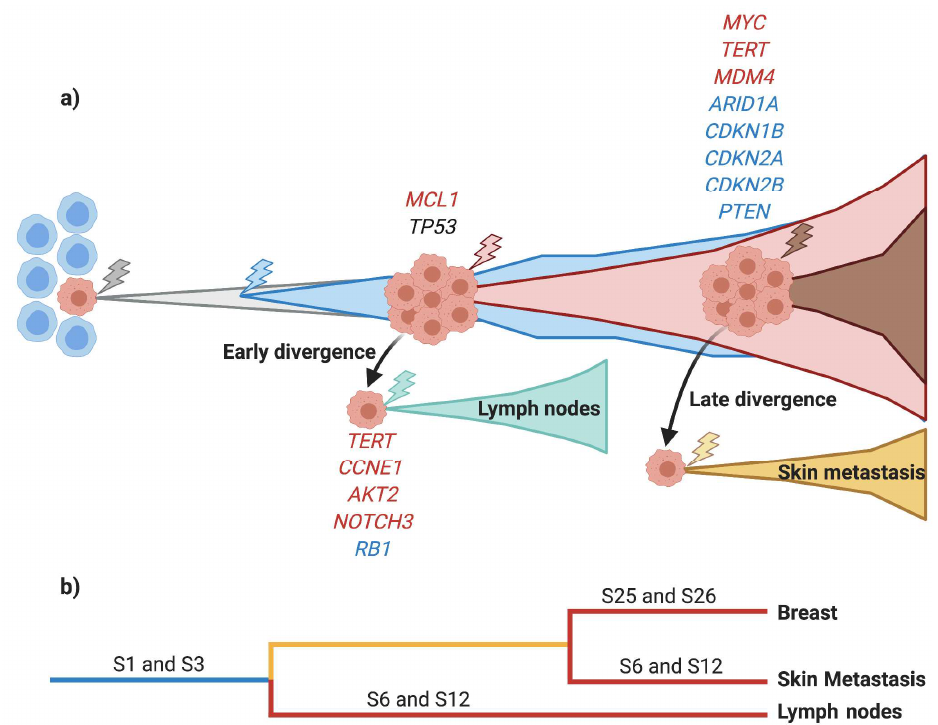
Figure 6. Summary of the key conclusions from our study. ( a ) Tumor evolution of TNBC seen in our cohort. We identified an early and late divergence to lymph nodes and skin metastasis, respectively. Driver genes with SNV (black), amplifications (red), and deletions (blue) are shown at each stage of TNBC carcinogenesis. ( b ) Phylogenetic tree of mutational signatures shows the main signatures acquired in each sample. Truncal mutational signatures are indicated in blue, shared signatures in yellow, and private signatures in